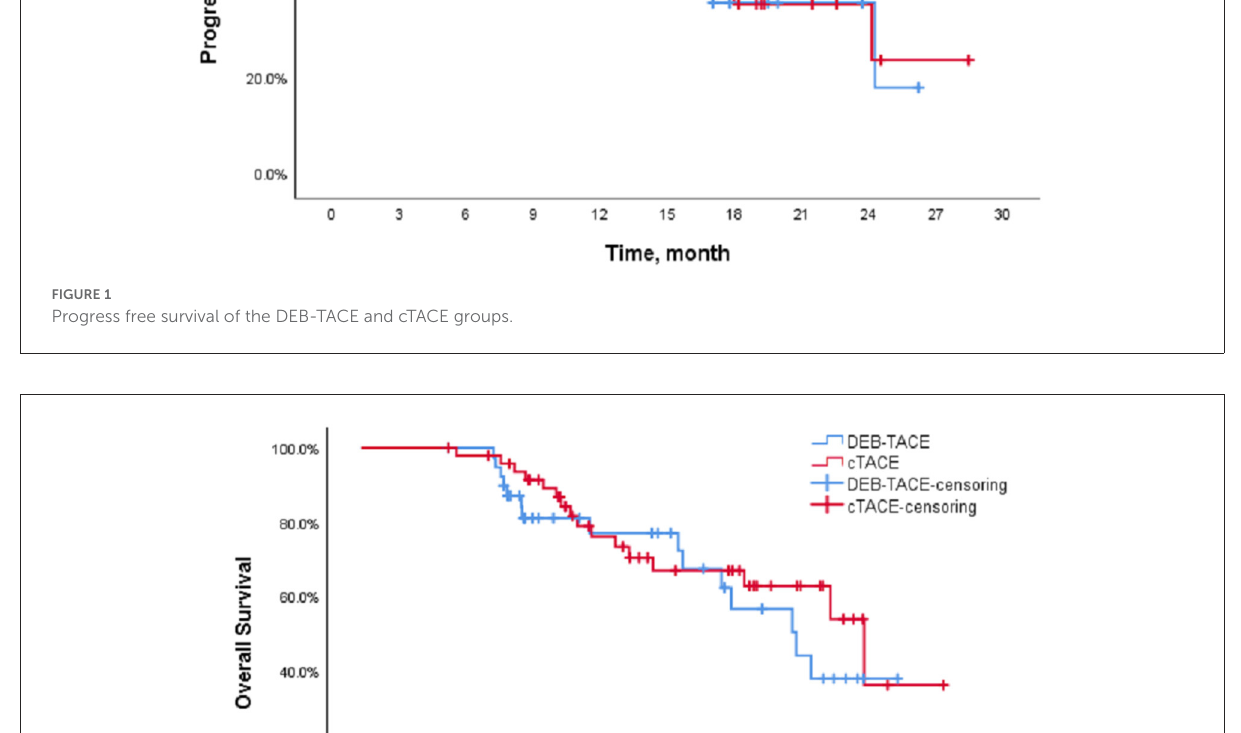
Through follow-up, the disease progression and survival of patients during the follow-up period can be known. In order to simulate the entire life cycle of patients, it is necessary to fit the survival of patients. The individual patient data were analyzed using the surveyHE data package in the R language, and the Log-normal parameter distribution was obtained as the best fitting model (17). The parameters of the log-normal